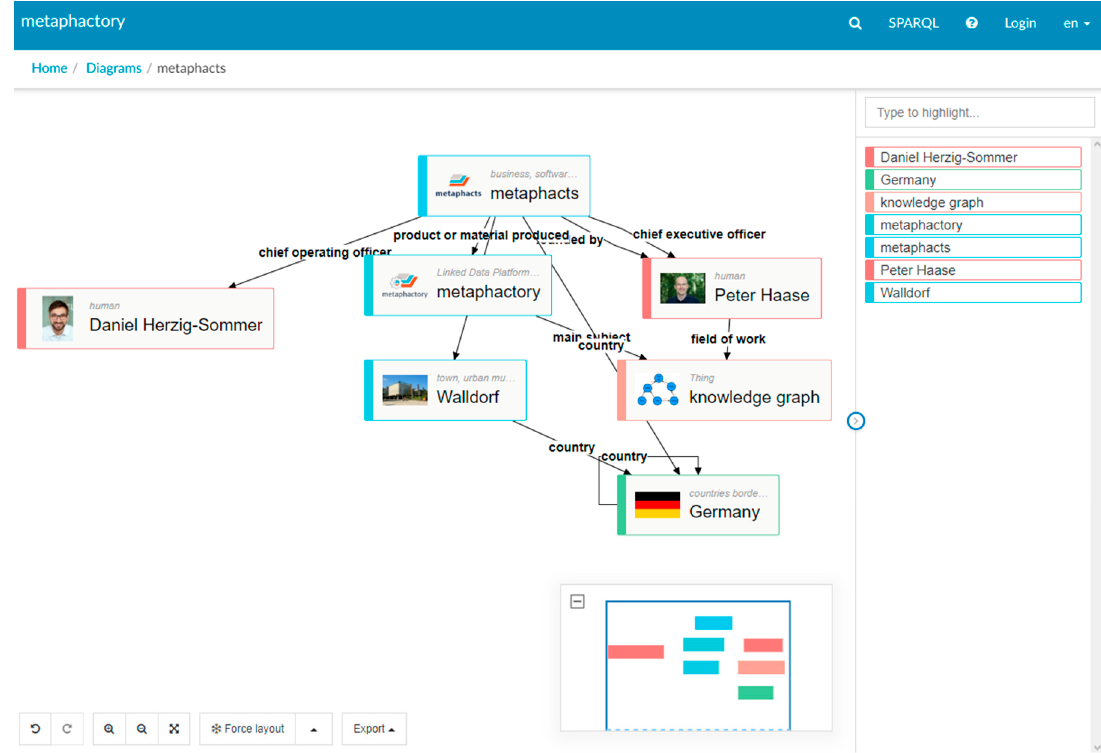
Figure 4. Ontodia (now contained within the Metaphactory software suite): List, context, and details subviews. Source: Image with permission courtesy of Metaphacts, metaphacts.com.